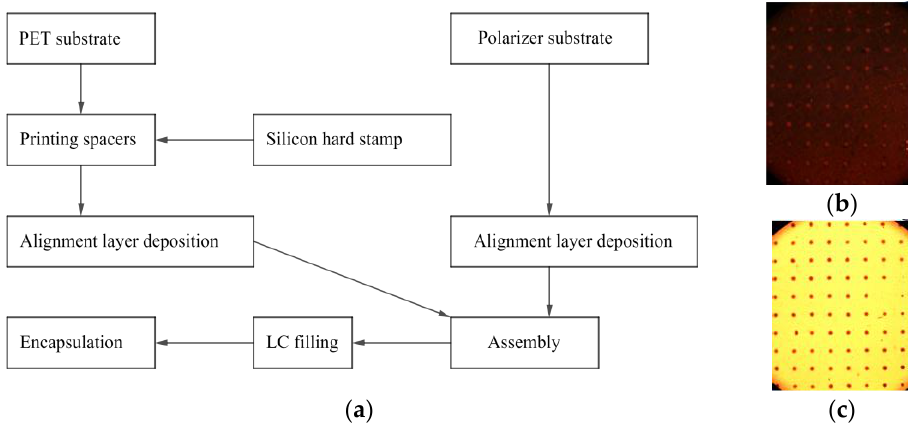
Figure 2. Color online. ( a ) Flowchart of the manufacturing process of optically rewritable electronic paper; photomicrographs of ( b ) planar and ( c ) twisted NLC orientations. Cylindrical spacer diameter: Δ L = 20 µm; distance between spacers: L = 2 00 μm.